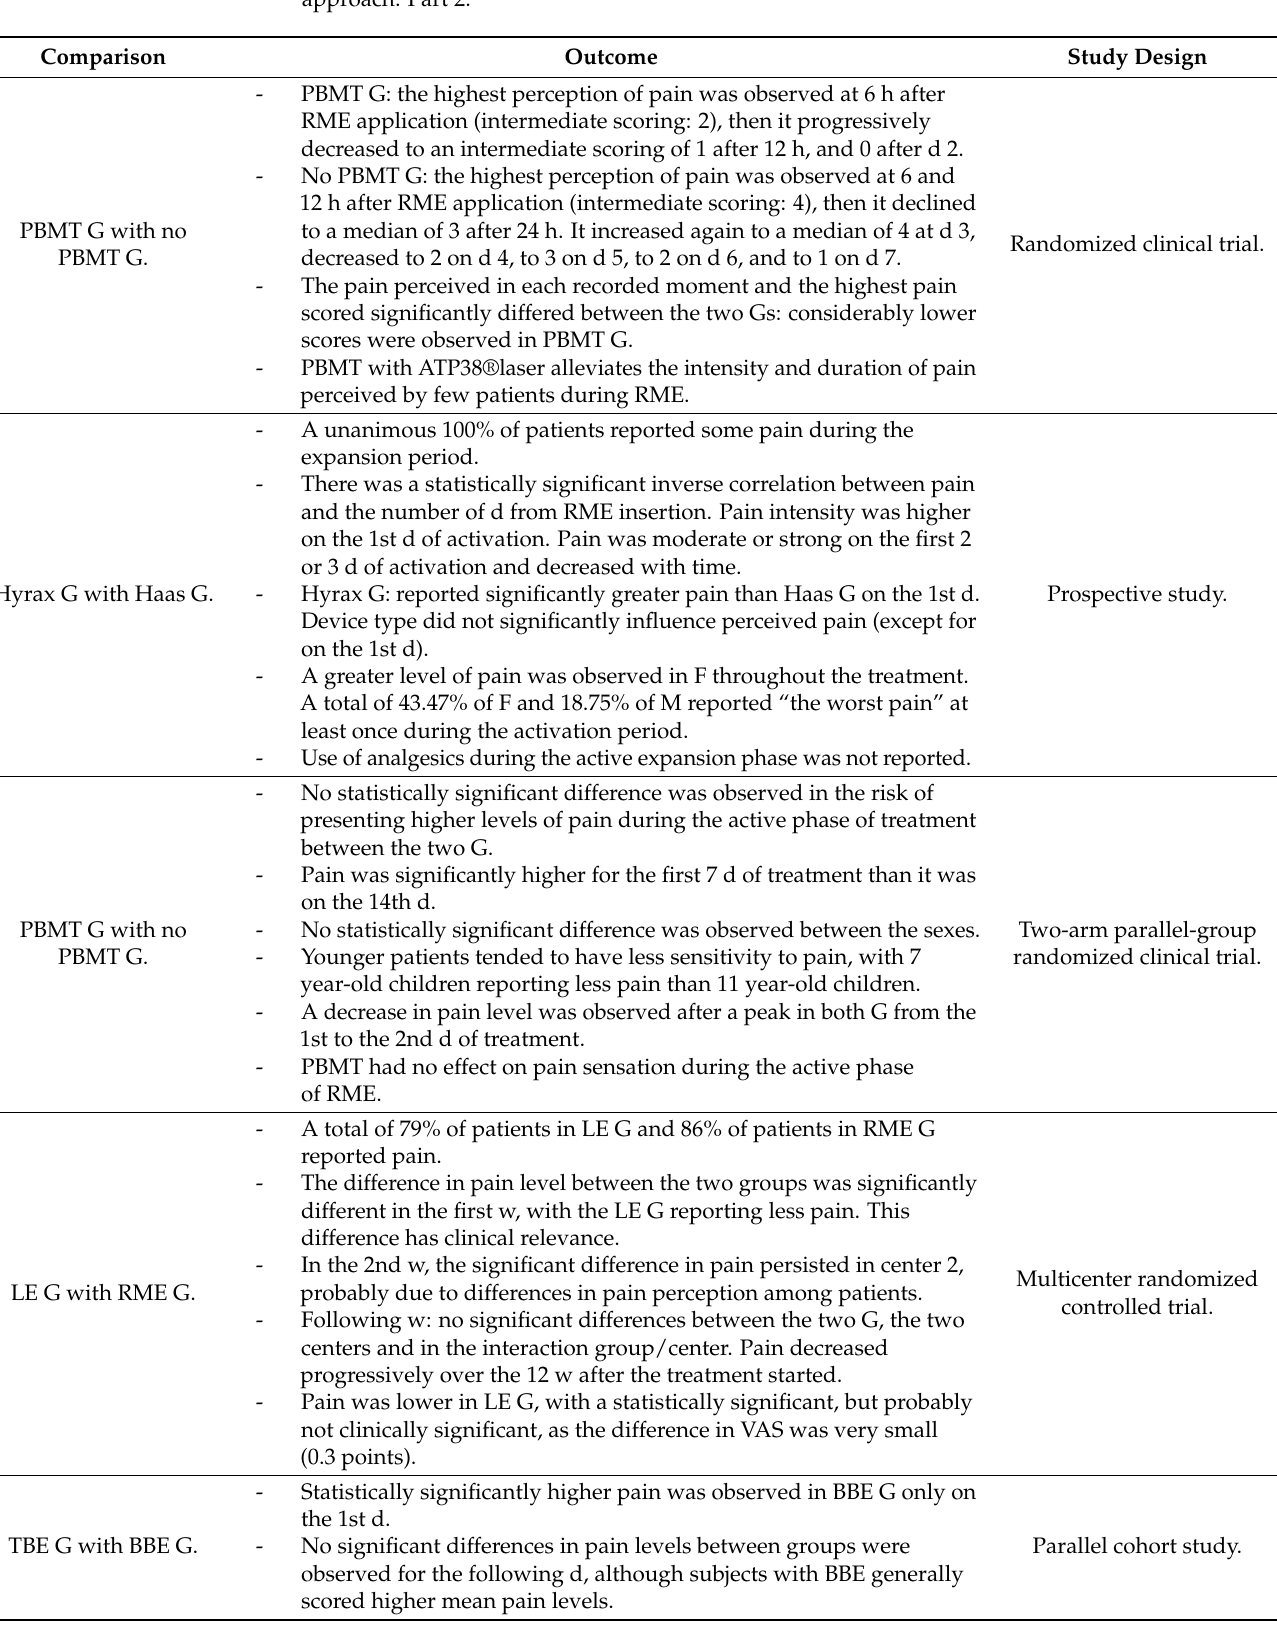
Table 3. Characteristics and main data of the reviewed studies, extracted according to the PICOS approach. Part